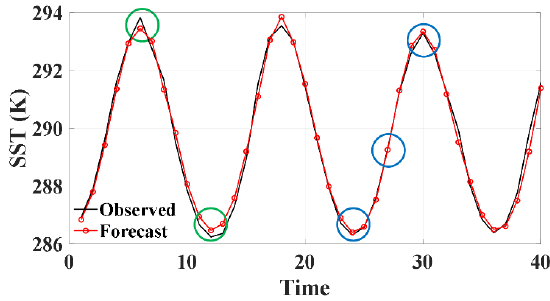
Figure 4. Self-attention smoothing strategy.